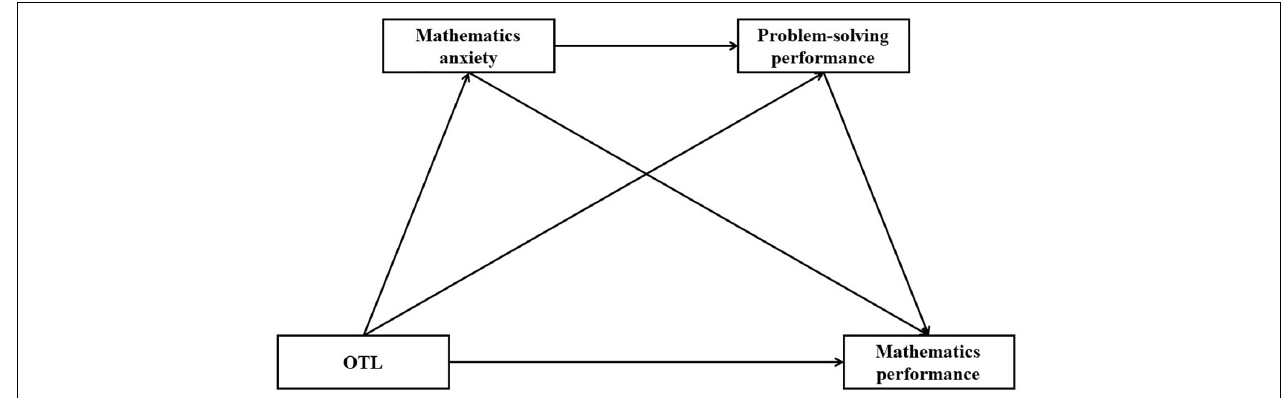
FIGURE 1 | Theoretical